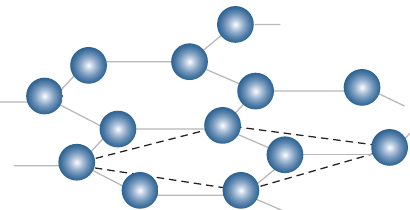
Figure 1: Schematic view of monolayer graphene. The dotted line denotes the unit